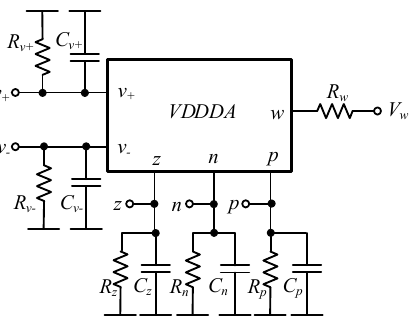
Figure 6. The parasitic effects on the VDDDA.